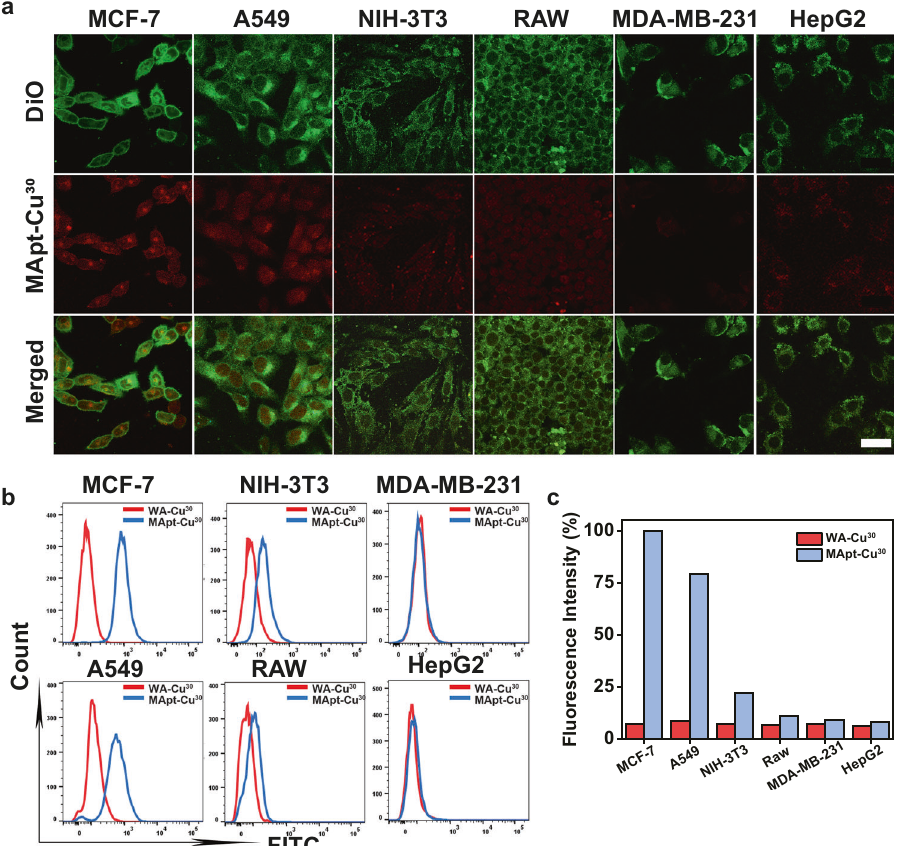
Fig. 3 Speci fi c recognition of target cells by MApt-Cu 30 and WA-Cu 30 . a Confocal microscopy images of MCF-7, A549, NIH-3T3, RAW, MDA-MB-231, and HepG2 cells treated with MApt-Cu 30 (copper 5 µ M); Images are representative of three independent biological samples. scale bars: 50 µ m. b Flow cytometry assay of different cells treated with MApt-Cu 30 and WA-Cu 30 (copper 5 µ M), respectively. c Quantitative analysis of fl uorescence intensity of MApt-Cu 30 and WA-Cu 30 internalized into different cells by fl ow cytometry. In the section of Fig. 3b, c FAM-labeled MUC1 aptamer was used to prepare MApt-Cu 30 for fl uorescence assay. Source data are provided as a Source Data fi